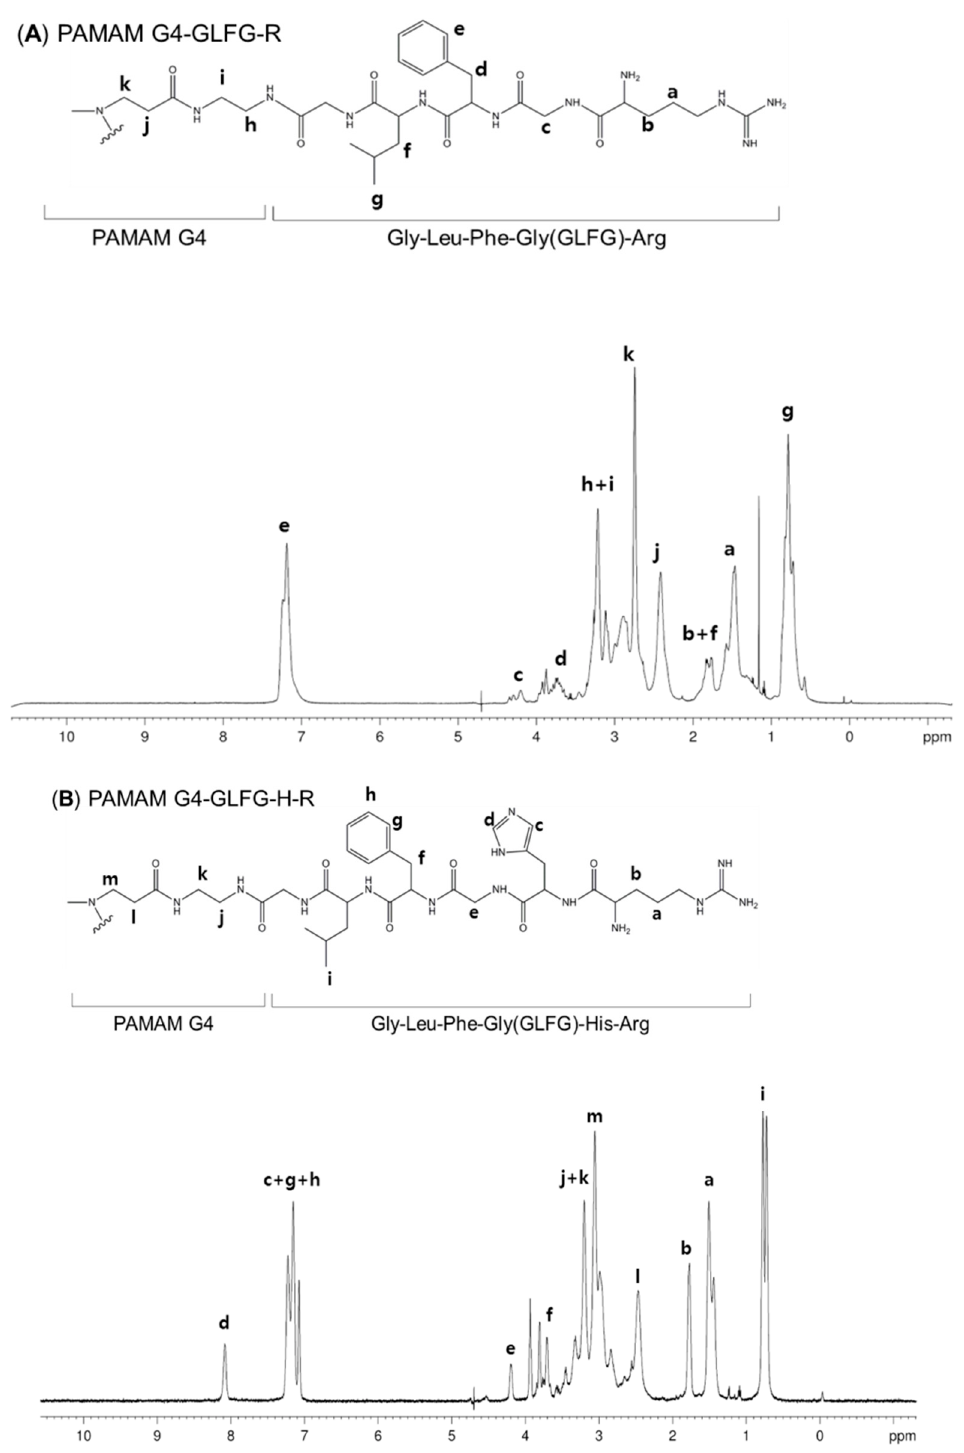
Figure 3. 1 H NMR data of ( A ) PAMAM G4-GLFG-R and ( B ) G4-GLFG-H-R.